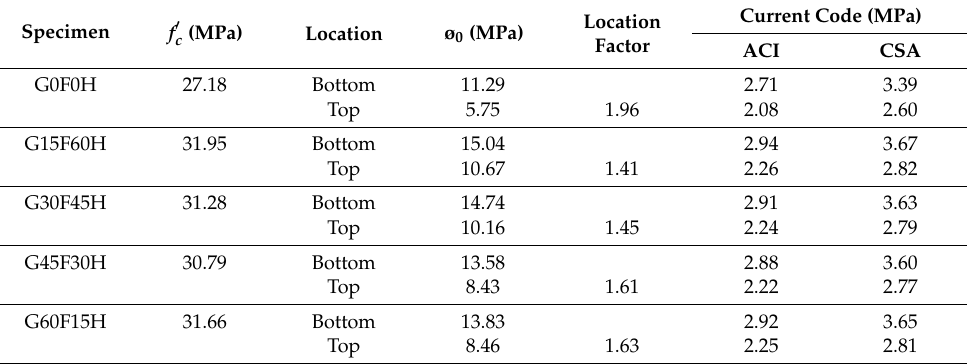
Table 8. Bond strengths of H-type specimens.